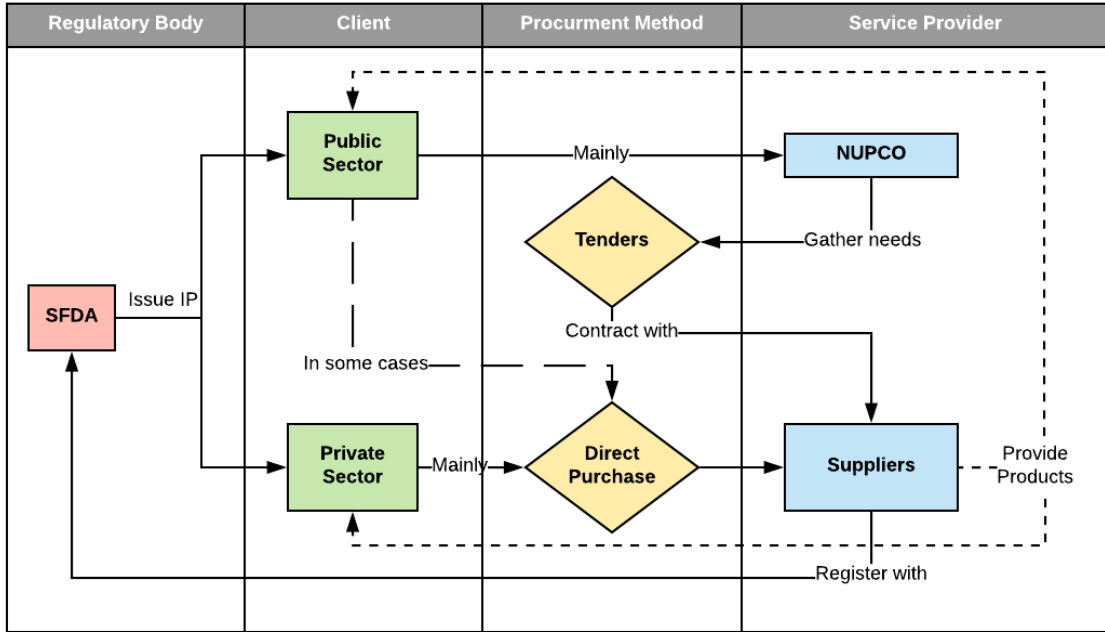
Figure 1. The procurement methods, main stakeholders, and processes.